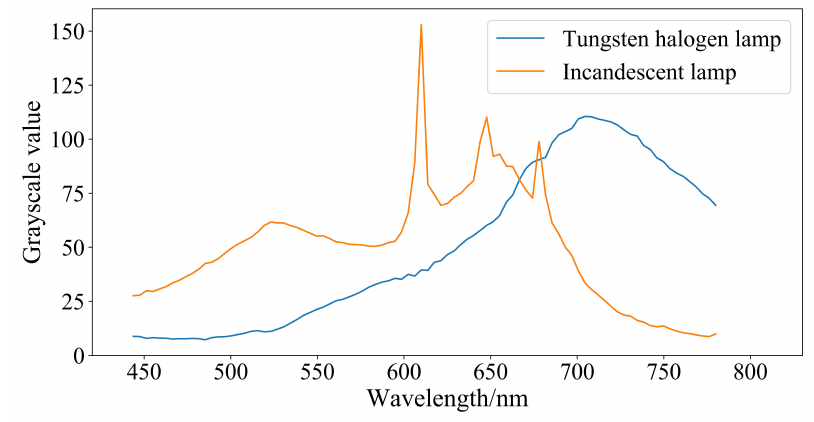
Figure 11. Spectra of the incandescent lamp and the tungsten halogen lamp. The position and orientation of the tungsten halogen lamp and the attitude of the model were changed to simulate the changes in the spectral data distributions produced by different shooting times, attitudes of the space target, and other conditions, as shown in Figure 12. Then, the measured hyperspectral images of different illumination conditions and different spatial resolutions were obtained by adjusting the spatial resolution of the measuring instrument.